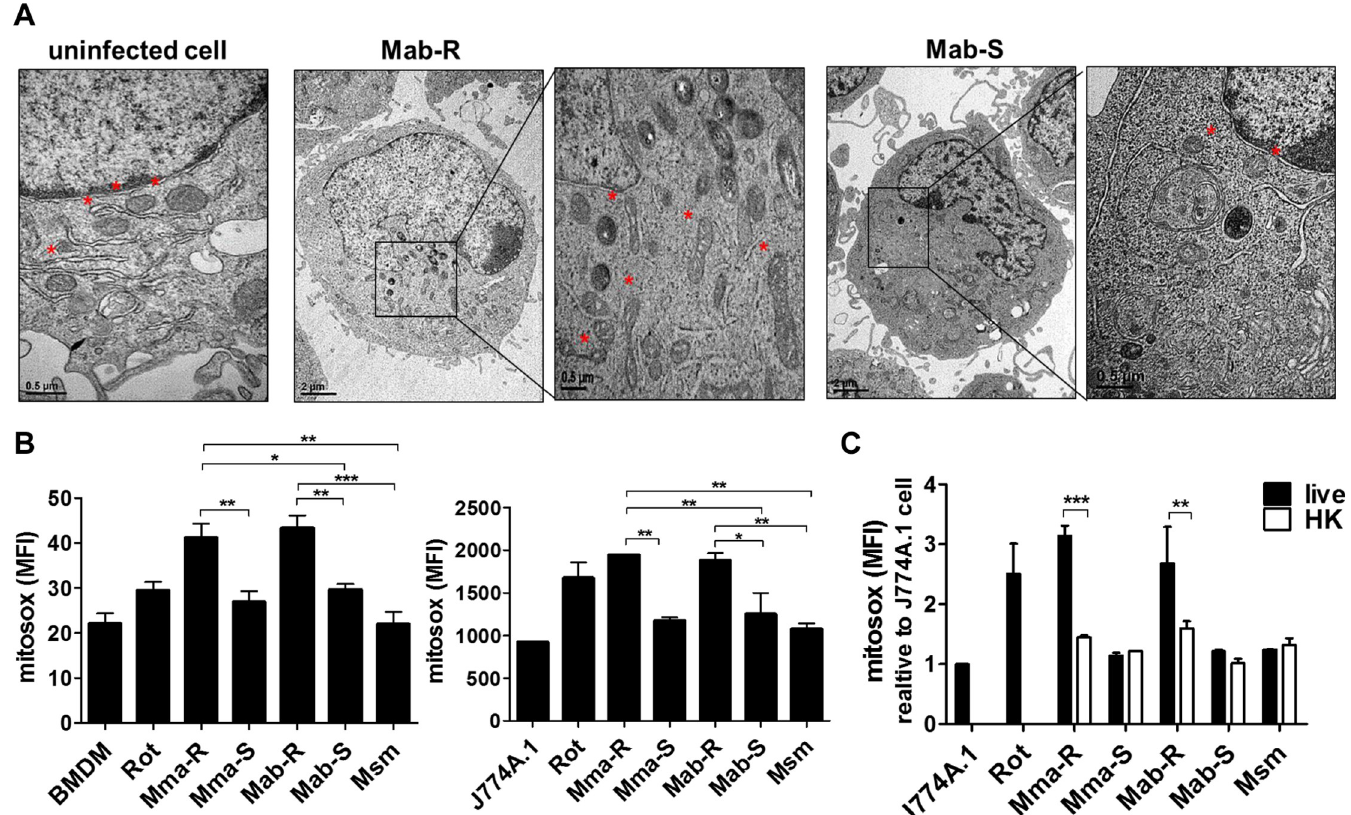
Fig 1. MAB-R strains enhanced mtROS in infected murine macrophages compared to the effects of MAB-S strains. (A) Representative TEM images of BMDMs infected with Mab-R or -S strains at an M.O.I. of 10 for 24 h. As a control, representative images of uninfected cells are shown. The mitochondrial morphology in infected cells and their magnified images are shown (black box region and marked with a red asterisk). Bar indicates 0.5 or 2 μ m. (B) To evaluate mtROS (MitoSOX), BMDMs or J774A.1 cells were infected with strains of MAB-R, MAB-S or M . smegmatis (Msm) at an M.O.I. of 10 for 24 h. Additionally, cells were pre-treated with rotenone (Rot; 5 μ M) as a positive control (for induction of ROS) for 30 min. The infected cells were stained with MitoSOX and then analysed by flow cytometry (FACSCalibur). (C) Induced mtROS levels in J774A.1 cells infected with live or heat-killed (HK) mycobacteria (M.O.I. of 10) for 24 h were measured by flow cytometry (FACSCalibur). Error bars represent the SD. Statistical significance was determined by ANOVA with Tukey’s multiple comparison test (B and C) and two-tailed Student’s t -test